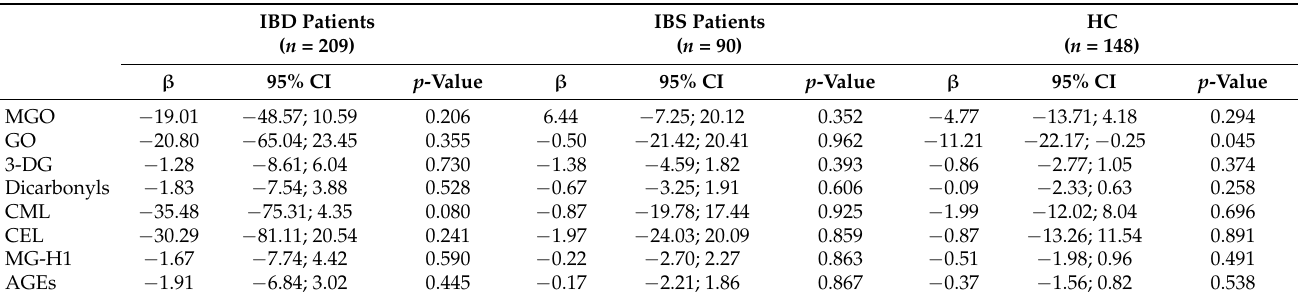
Table 3. Multivariable linear regression of absolute dietary intake of dicarbonyls and advanced glycation endproducts with faecal